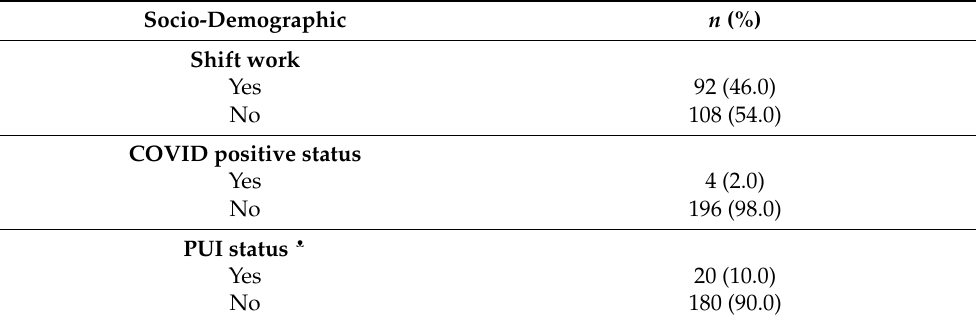
Table 2. Scores and cut-offs of the Hospital Anxiety and Depressive Scale (HADS) ( n = 200). Measures